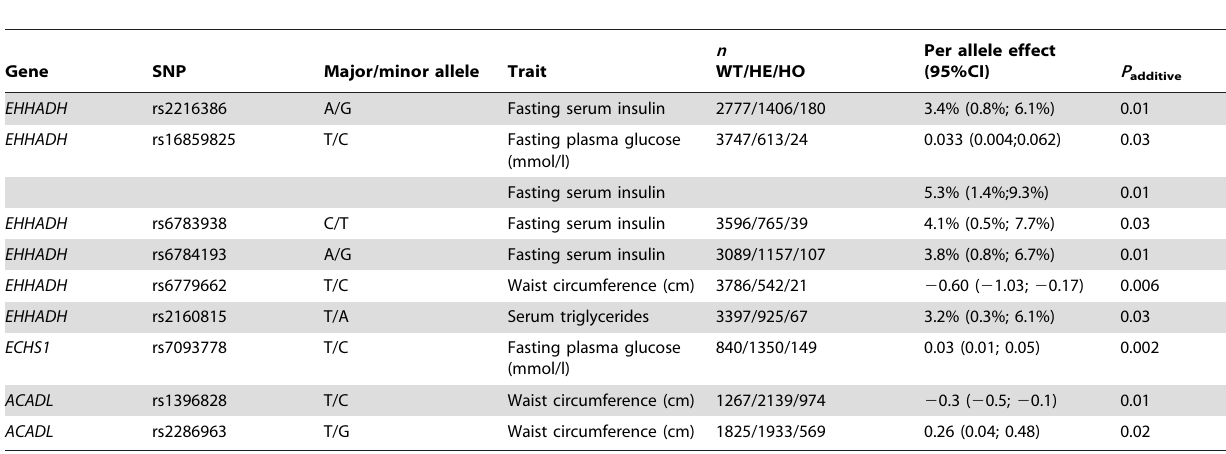
Table 1. Nominal statistically significant associations with NAFLD-related traits in the quantitative trait analyses in ( n =4,567) glucose-tolerant